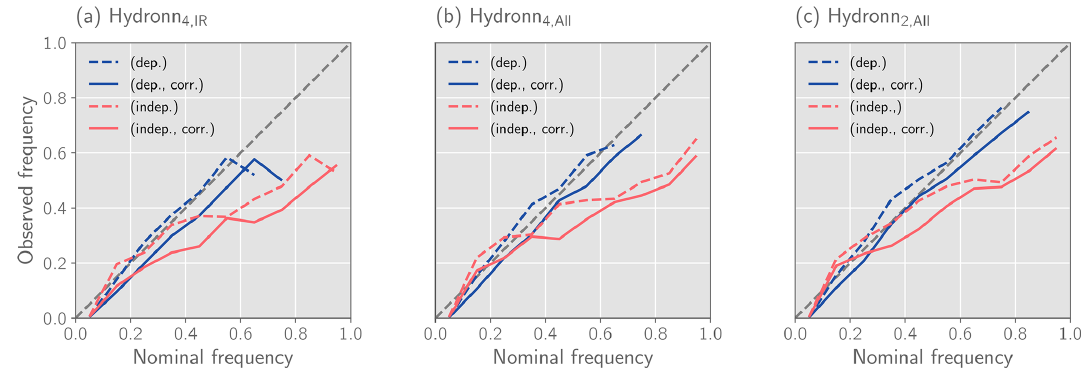
Figure 17. Calibration of the probabilistic precipitation event detection for precipitation exceeding 5mmh − 1